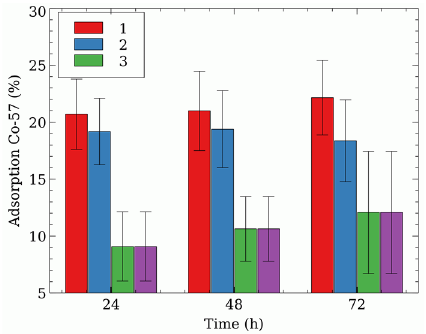
Figure 6. The effect of the solution composition on the efficiency of sorption extraction of Co-57 by resin KU 2-8. 1—NaNO 3 (3 mol/L), 2—H 2 SO 4 (0.1 mol/L), NaNO 3 (3 mol/L), 3—H 2 SO 4 (1.0 mol/L), NaNO 3 (3 mol/L), 4—H 2 SO 4 (2.0 mol/L), NaNO 3 (3 mol/L). Solution volume—100 mL, resin vol- ume—2 mL, contact time—48